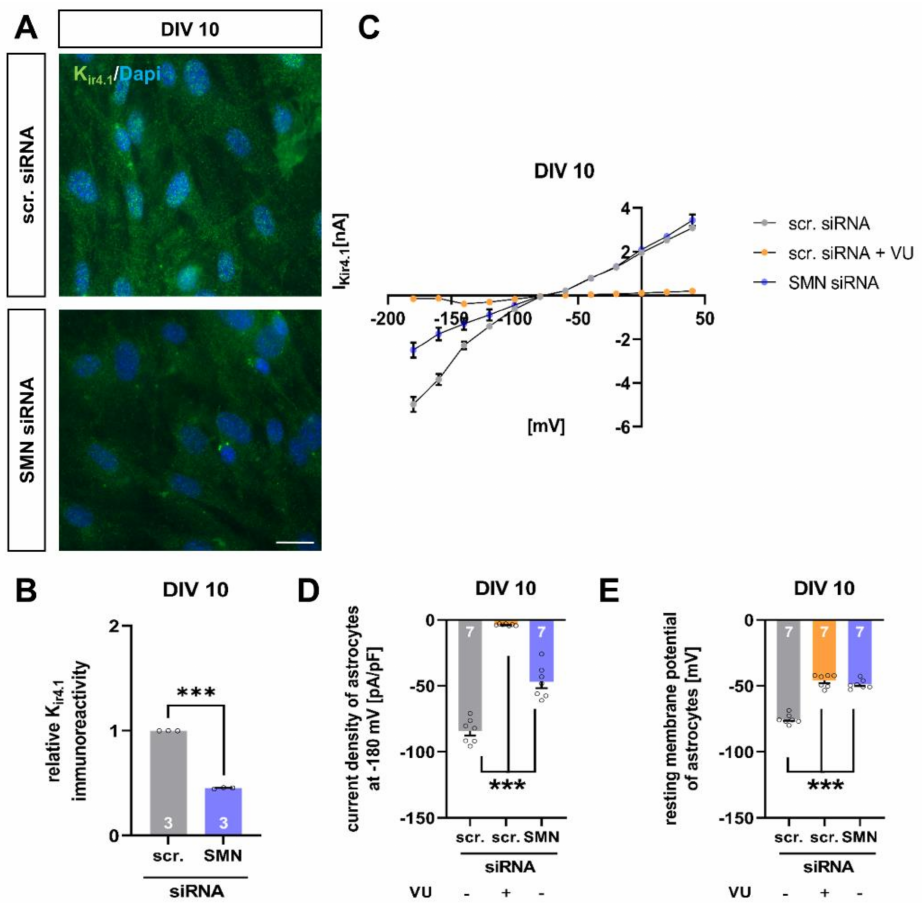
Figure 4. SMN-deficient spinal astrocytes show a reduction in K ir4.1 protein level and modulation in electrophysiological properties. ( A ) Immunostaining of wild-type astrocyte cultures transfected with scrambled (scr.) or SMN siRNA against K ir4.1 protein (green) at DIV 10. Nuclear DNA was stained with Dapi (blue). ( B ) SMN-deficient spinal astrocytes showed reduced protein levels of K ir4.1 , compared to astrocytes transfected with scrambled siRNA (***, p < 0.001). ( C ) Raw trace of current– voltage (IV) curve of K ir4.1 channel protein in cultured spinal astrocytes transfected with scrambled or SMN siRNA or scrambled siRNA + K ir4.1 inhibitor VU. SMN-deficient astrocytes showed reduced current as a sign of reduced potassium uptake into spinal astrocytes. A similar effect was observed when VU inhibited the Kir4.1 function. ( D ) Current density of K ir4.1 was reduced in SMN-deficient spinal astrocytes, compared to astrocytes transfected with scrambled siRNA (***, p < 0.001). When K ir4.1 function was inhibited in wild-type astrocytes exposed to scrambled siRNA, the current density was reduced (***, p < 0.001). ( E ) Astrocytes transfected with SMN siRNA showed depolarized resting membrane potential (***, p < 0.001). A similar result was observed when K ir4.1 function was inhibited by VU (***, p < 0.001). n = 3 independent experiments for immunostaining (see bars). For each experiment > 50 cells were analyzed. n = 7 cells per electrophysiological measurement (see bars). Scale bar: 50 µ